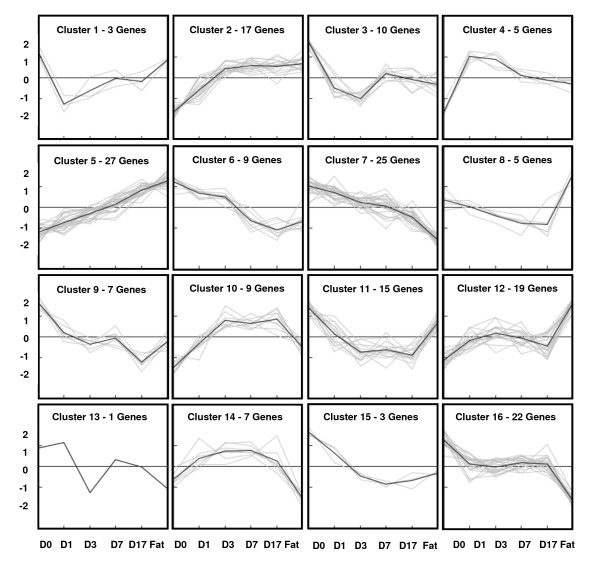
K-Means cluster analysis of adipogenic gene expression profile. 184 candidate genes possibly associated with adipogenesis were clustered into 16 different groups (C: Cluster) depending on the individual expression levels (K-means clustering method). The intensity is shown by numbers on the left border, the expression levels are illustrated by means of the cluster images.